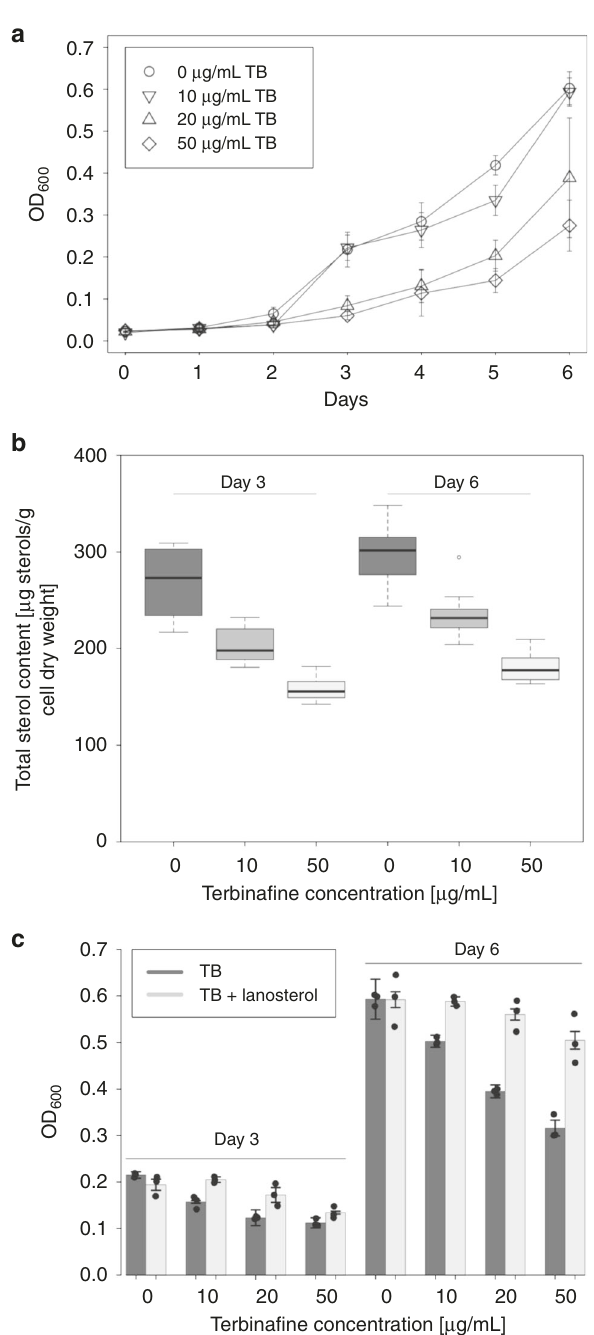
division, including cells with multiple buds and closed neck between cells (Fig. 2g, h). In contrast to wild-type dividing cells, the membranes at the bud of the necks in mutant cells seem to be occluding the length of the neck (Fig. 2a, g, h).